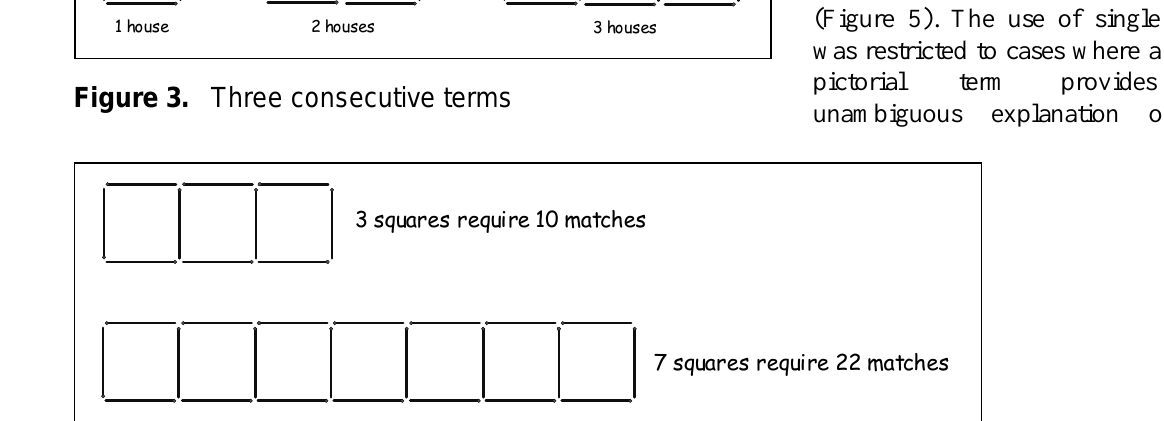
Figure 4. Two non-consecutive terms